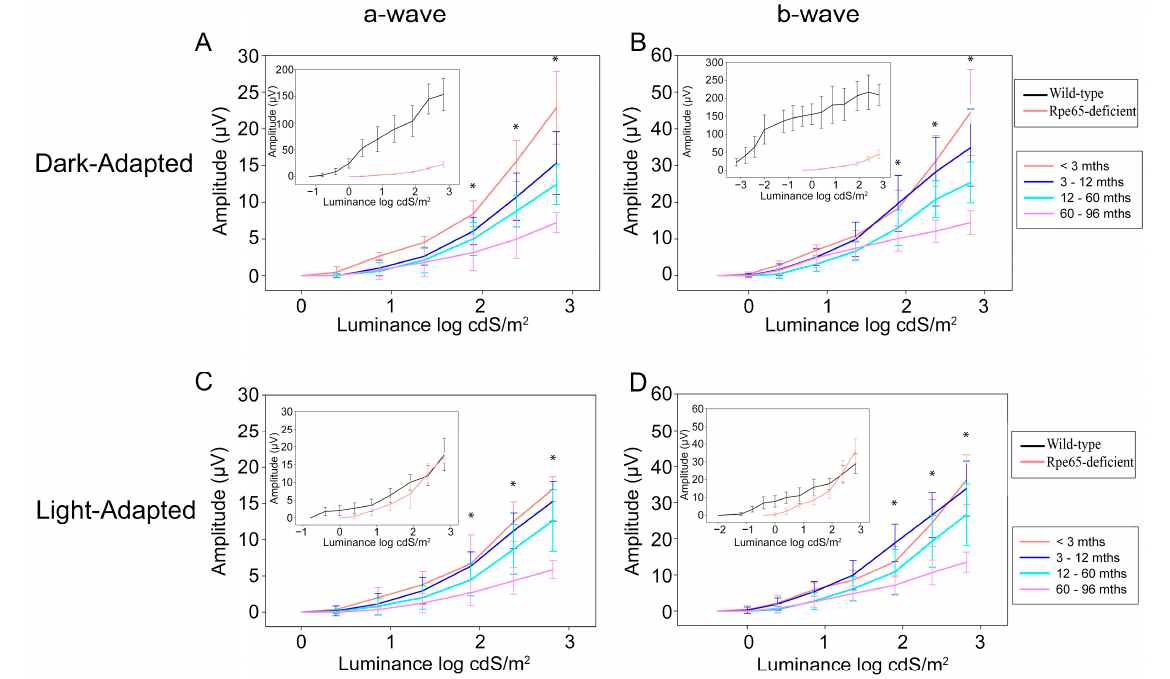
Figure 4. Mean ( ± SD) ERG amplitude stimulus–response plots in dark- and light-adapted eyes. In each instance, the insert compares the mean wild-type amplitudes of wild-type controls with the 2–3-month-old Rpe65-deficient dogs (note difference in response threshold between wild-type and Rpe65-deficient dogs). ( A , B ) Dark-adapted and ( C , D ) light-adapted mean a-wave ( A , C ) and b-wave ( B , D ). Note that amplitudes reduce significantly with age (* indicates flash stimuli with a significant change in amplitude [ p < 0.05] with age) <3 months, n = 8 eyes; 3–12 months, n = 34 eyes; 12–60 months, n = 28 eyes; 60–96 months, n = 8 eyes. Wild-type control dogs: 9–12 months, n = 10